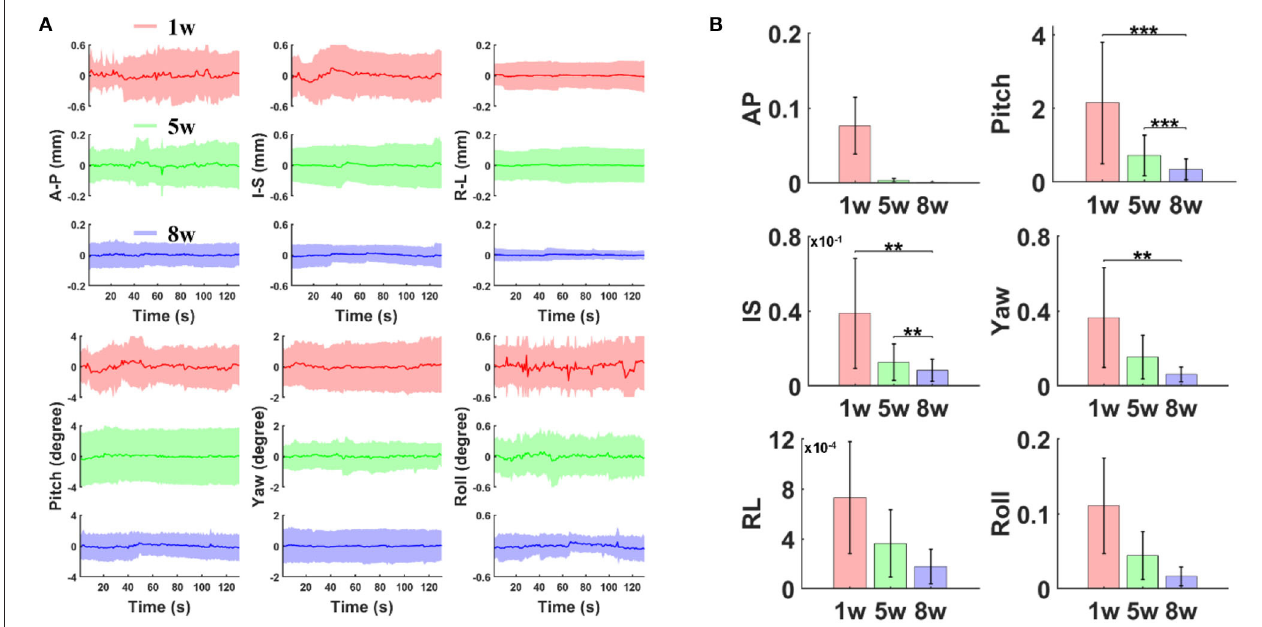
FIGURE 2 | The estimated motion parameters during intermittent acclimation from different weeks. (A) Averaged time course of translation displacement (A–P: anterior–posterior; I–S: inferior–superior; R–L: right–left) and rotations (pitch, yaw, and roll) after different weeks of training (first, fifth, eighth week; shaded regions: mean ± S.D, n = 6 animals). (B) Variance of translation and rotation time course (** p < 0.01, *** p < 0.001 by Bonferroni post-hoc test, error bars, S.E.M., n = 6 animals).